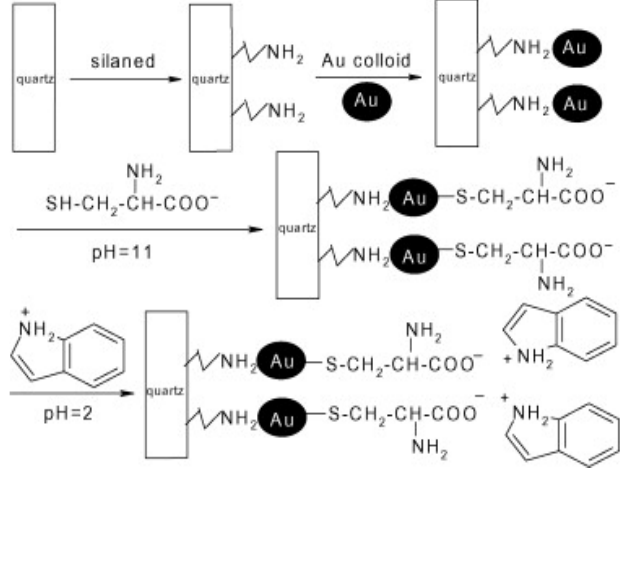
Figure 10. Schematic representation of the formation of the indole-based SAM sensor. Reproduced with permission from Reference [53], published by Elsevier,